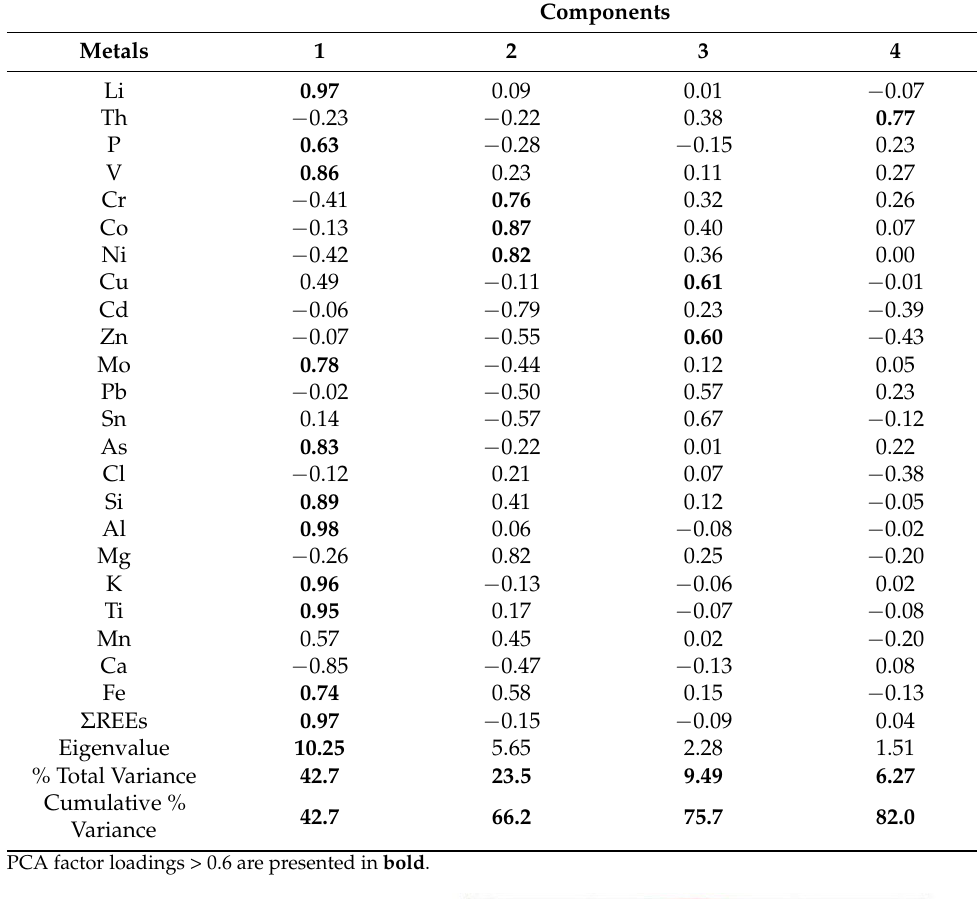
Table 9. PCA factor loadings for elements in studied samples.